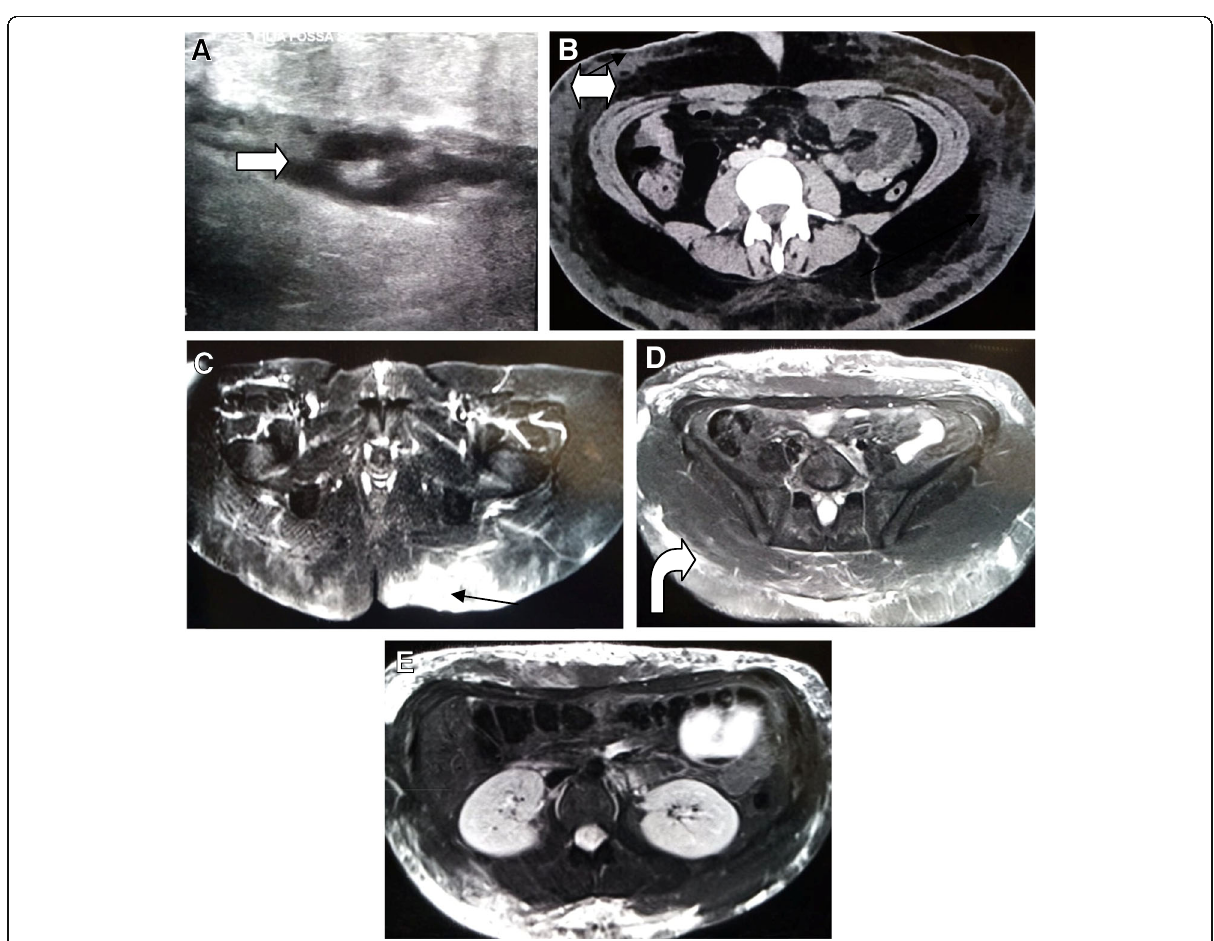
Fig. 2 Post lipofilling cellulitis. a Ultra sound study of the site of injection showing parietal edematous changes (open arrow). b Axial CT scan at higher level showing diffuse edematous changes of the anterior and posterior abdominal walls (double headed arrow). c , d , e Axial T2 Dixon with fat suppressed sequence showing diffuse edematous changes maximal at the left gluteal para median region (arrow in c , curved open arrow in d ) extending proximally to higher levels